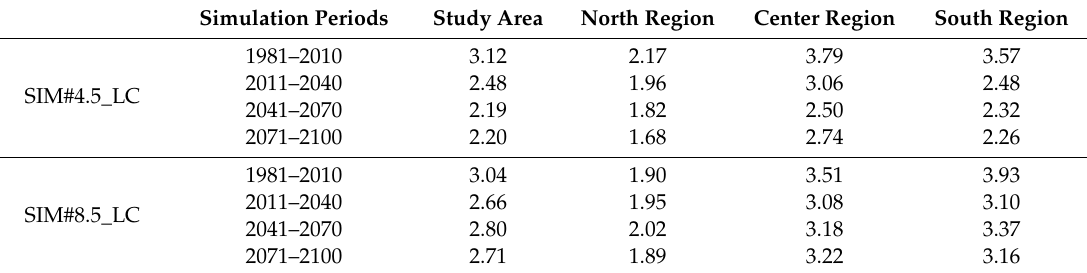
Figure 16. Soil erosion rate anomaly with respect to the reference period (1981–2010) for: 2011–2040 (first column), 2041–2070 (second column), and 2071–2100 (third column). SIM#4.5_LC (first row) and SIM#8.5_LC (second row). Table 9. Mean erosion rates [t ha − 1 yr − 1 ] according to climate and land cover